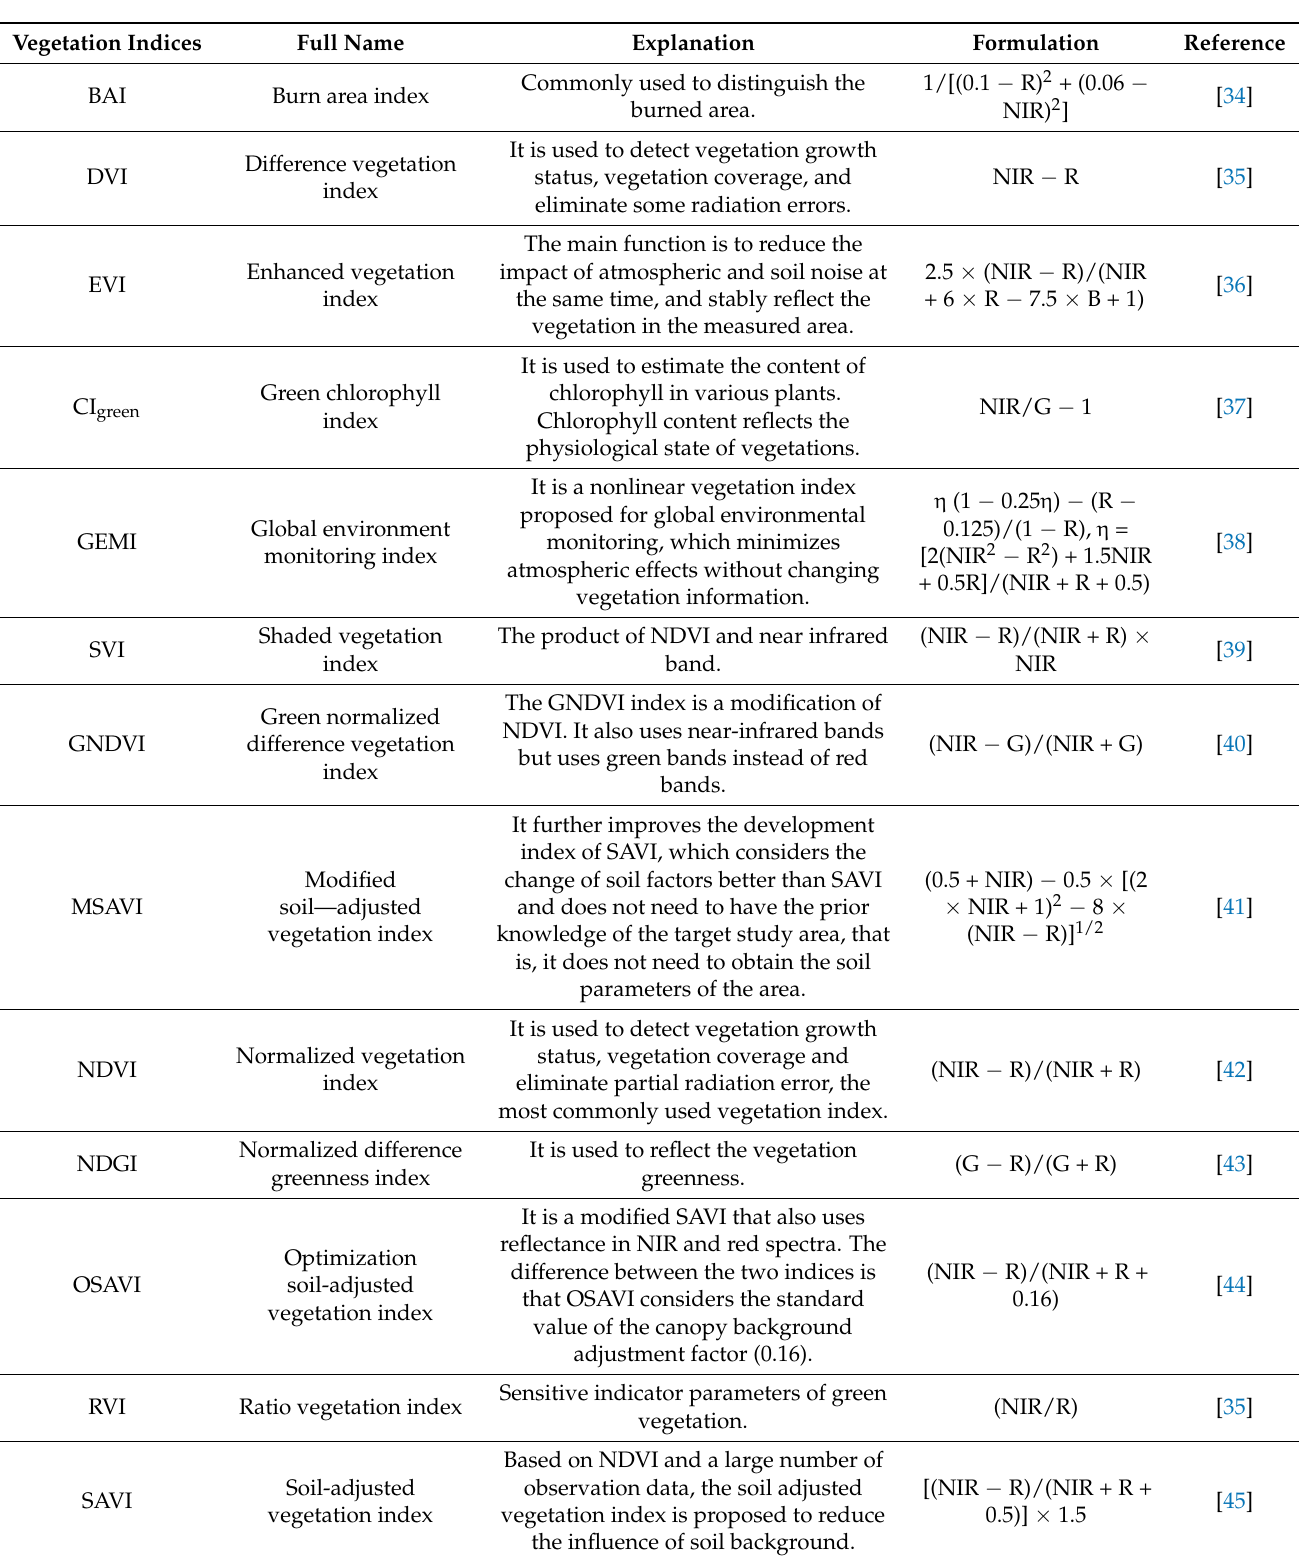
Table 4. Vegetation indices (B, G, R, and NIR represent the reflectivity of blue, green, red, and near-infrared bands,